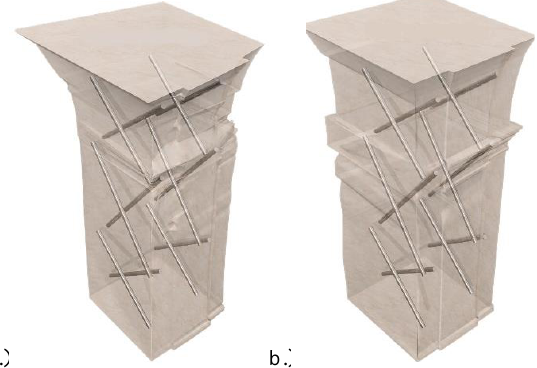
Figure 20. a.) 3D Model of column 2 with rebar disposition; b.) 3D Model of column 3 with rebar disposition.